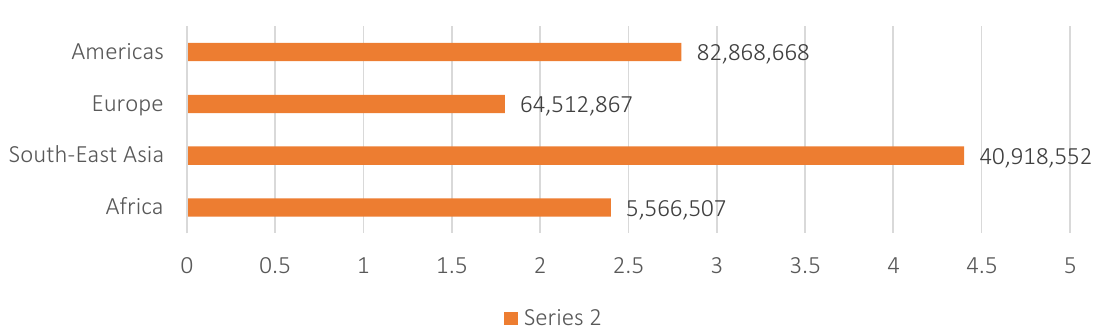
Figure 1. Total COVID-19 cases in some regions of the world